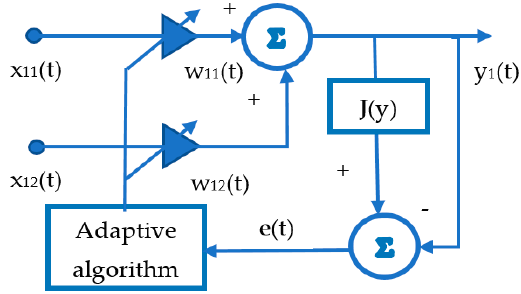
Figure 2. Single-layer neural network training.